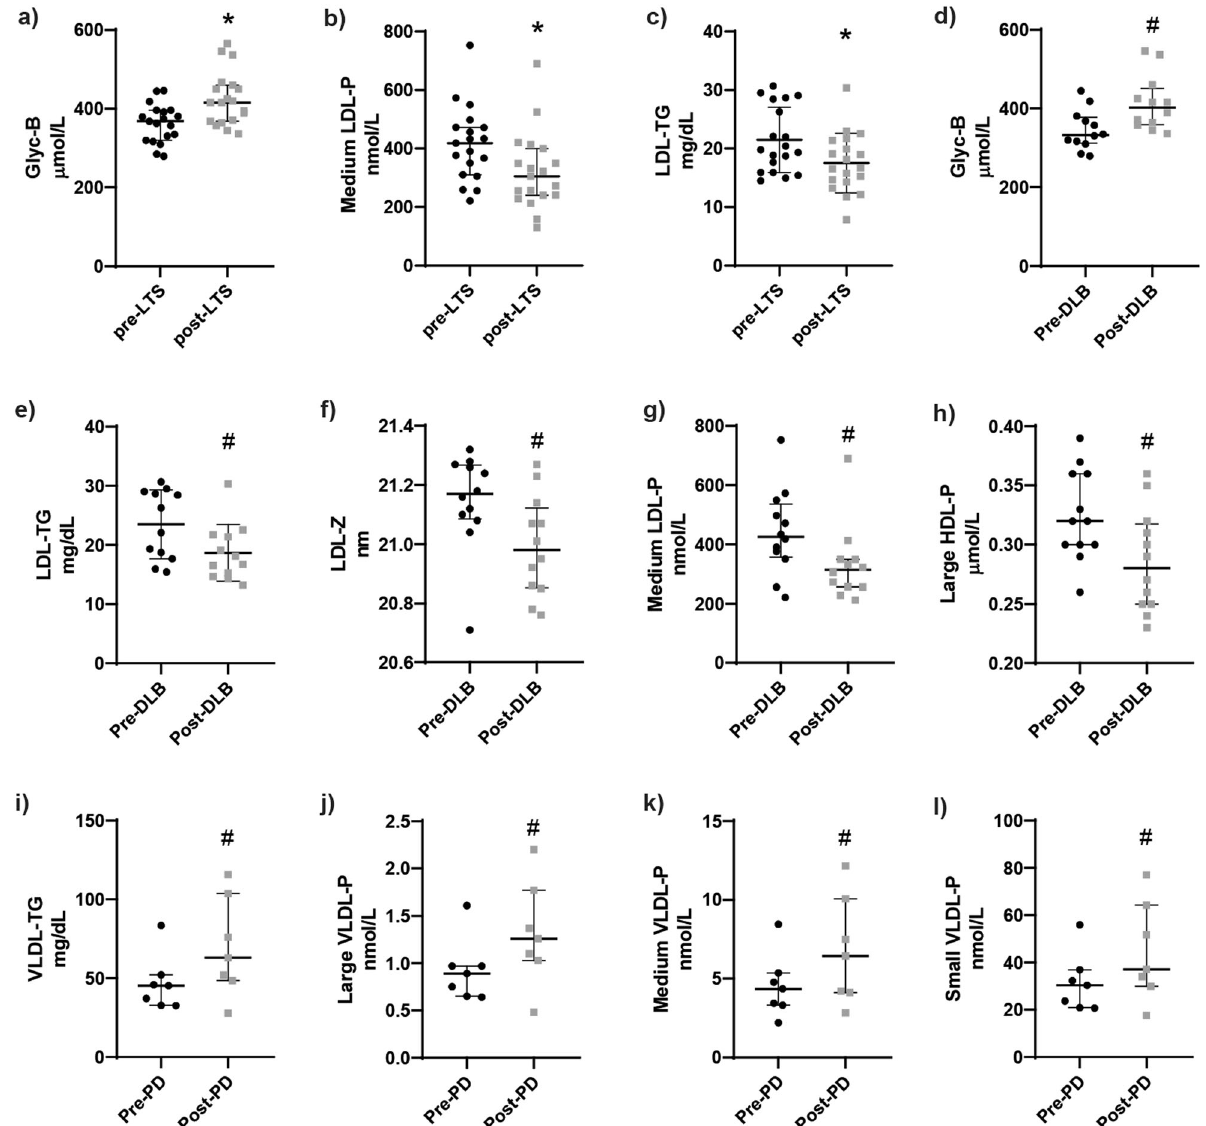
Fig. 1 Differences between iRBD patients before and after LTS diagnosis. Graphs of the a concentration of glycosylated protein B (Glyc-B), b concentration of medium sized LDL particles (medium LDL-P), and c concentration of triglycerides in LDL (LDL-TG) in the same iRBD patients, before (pre-) and after (post-) the diagnosis of LTS. Graphs of the d concentration of Glyc-B, e concentration of LDL-TG, f size of LDL (LDL-Z), g concentration of medium LDL-P, and h concentration of large HDL particles (large HDL-P) in the same IRBD patients, before (pre-) and after (post-) the diagnosis of DLB. Graphs of the i concentration of triglycerides in VLDL (VLDL-TG), j large VLDL particles (large VLDL-P), k medium VLDL particles (medium VLDL-P), and l small VLDL particles (small VLDL-P) in the same IRBD patients, before (pre-) and after (post-) the diagnosis of PD. Mean with interquartile range represented. Wilcoxon matched-pairs signed-rank test, combined with the Benjamini – Hochberg procedure to correct for false discovery rate (FDR). *FDR-adjusted p value < 0.05. # FDR-adjusted p value < 0.25.